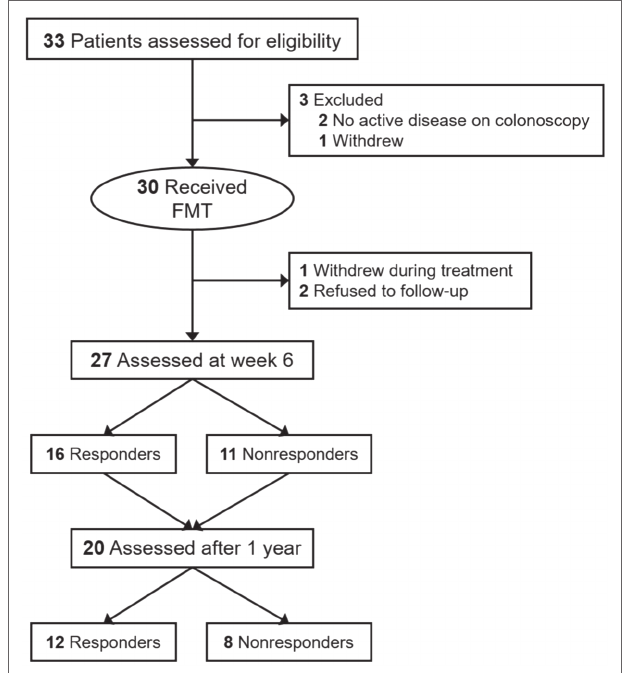
FIGURE 1 | Flow of patients of fecal microbiota transplantation (FMT) for ulcerative colitis.